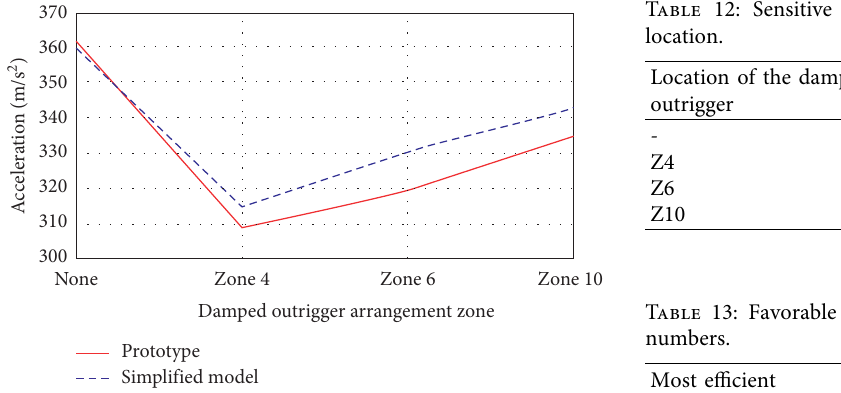
Figure 23: The vertex acceleration of the prototype and simplified model.